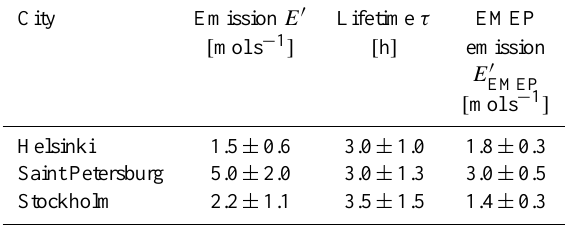
Table 1. Results of the emissions and lifetime (second and third column, respectively) calculation for Helsinki, Saint Petersburg and Stockholm with their total uncertainties. The emission data from the EMEP database are shown for comparison (last